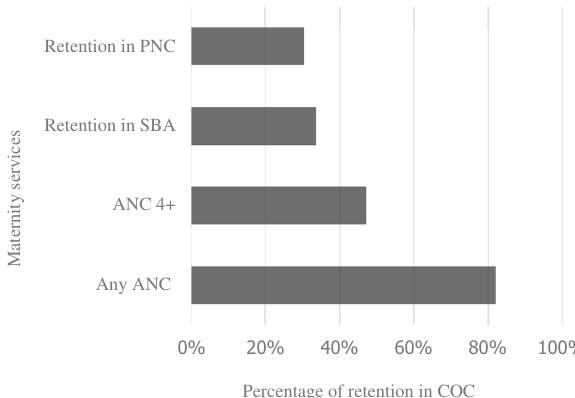
Figure 2. Maternal service utilization along the continuum of maternal care pathway from ANC to SBA and PNC: Bangladesh Demographic and Health Survey